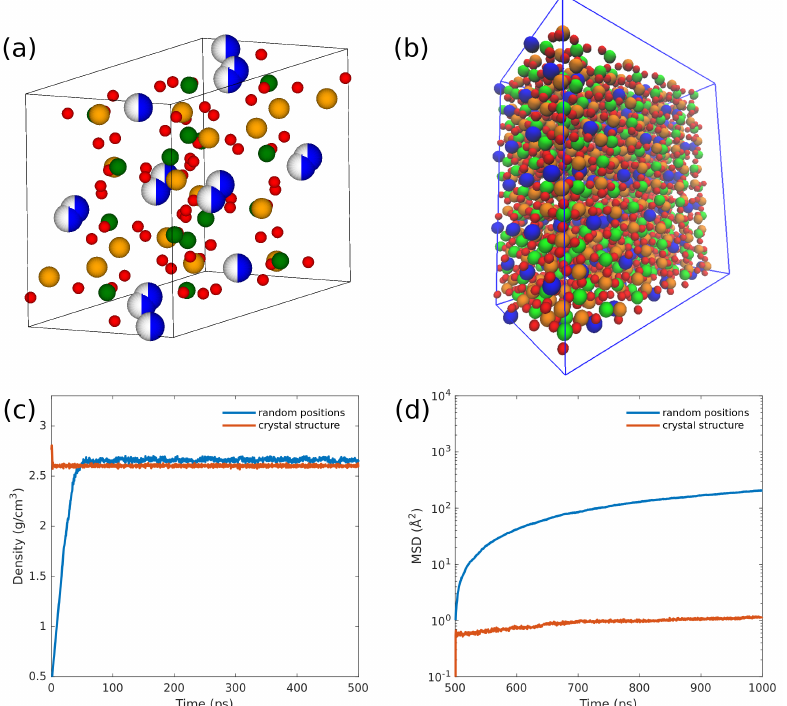
Figure 2. ( a ) Crystal structure of anorthite (CaAl 2 Si 2 O 8 [50]); Ca, Al, Si, and O atoms are represented by blue/white, orange, green, and red beads, respectively. ( b ) Example simulation box of anorthite with crystal structure initial configuration. ( c ) Simulated density of anorthite systems versus time with two different initial configurations for MD simulations. ( d ) Simulated mean square displacement versus time with those two different initial